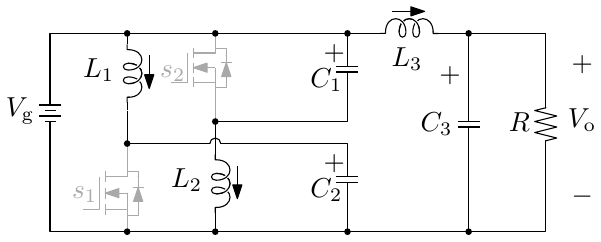
Figure 5. Equivalent circuit of switching state